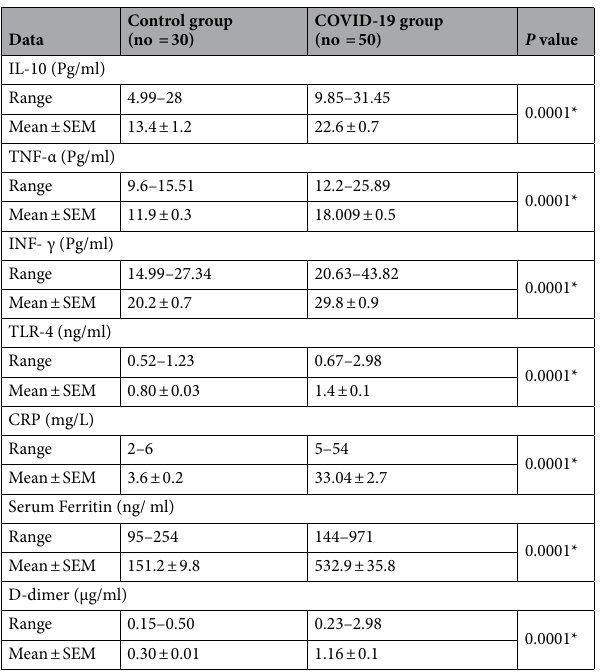
Table 2. The mean value ± SEM of the concentration levels of serum biomarkers in patients and controls. *Significant level at P value < 0.05.